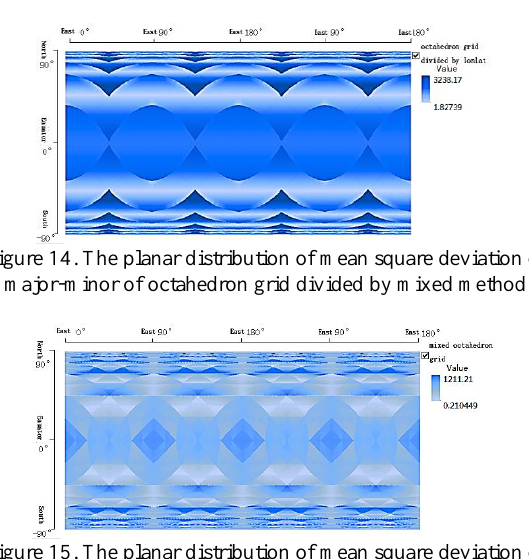
Figure 13. The planar distribution of mean square deviation of major-minor of octahedron grid divided by arc